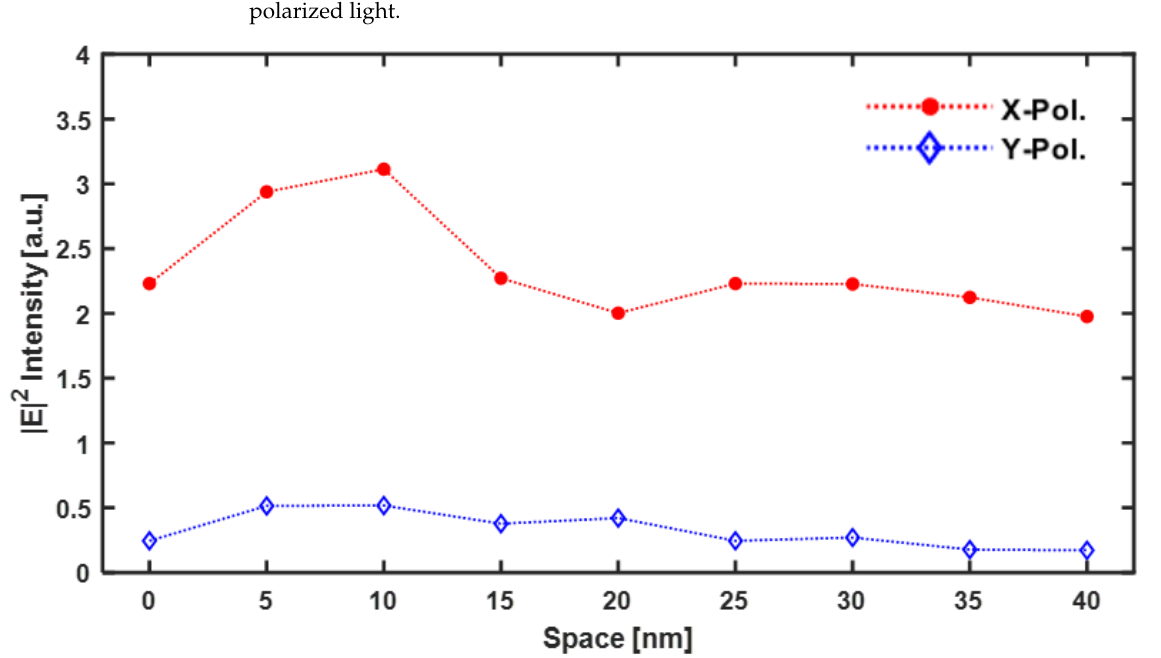
Figure 10. Difference in the maximum | E | 2 intensity from the bottom surface of ZnS-SiO 2 layer due to polarization dependence.